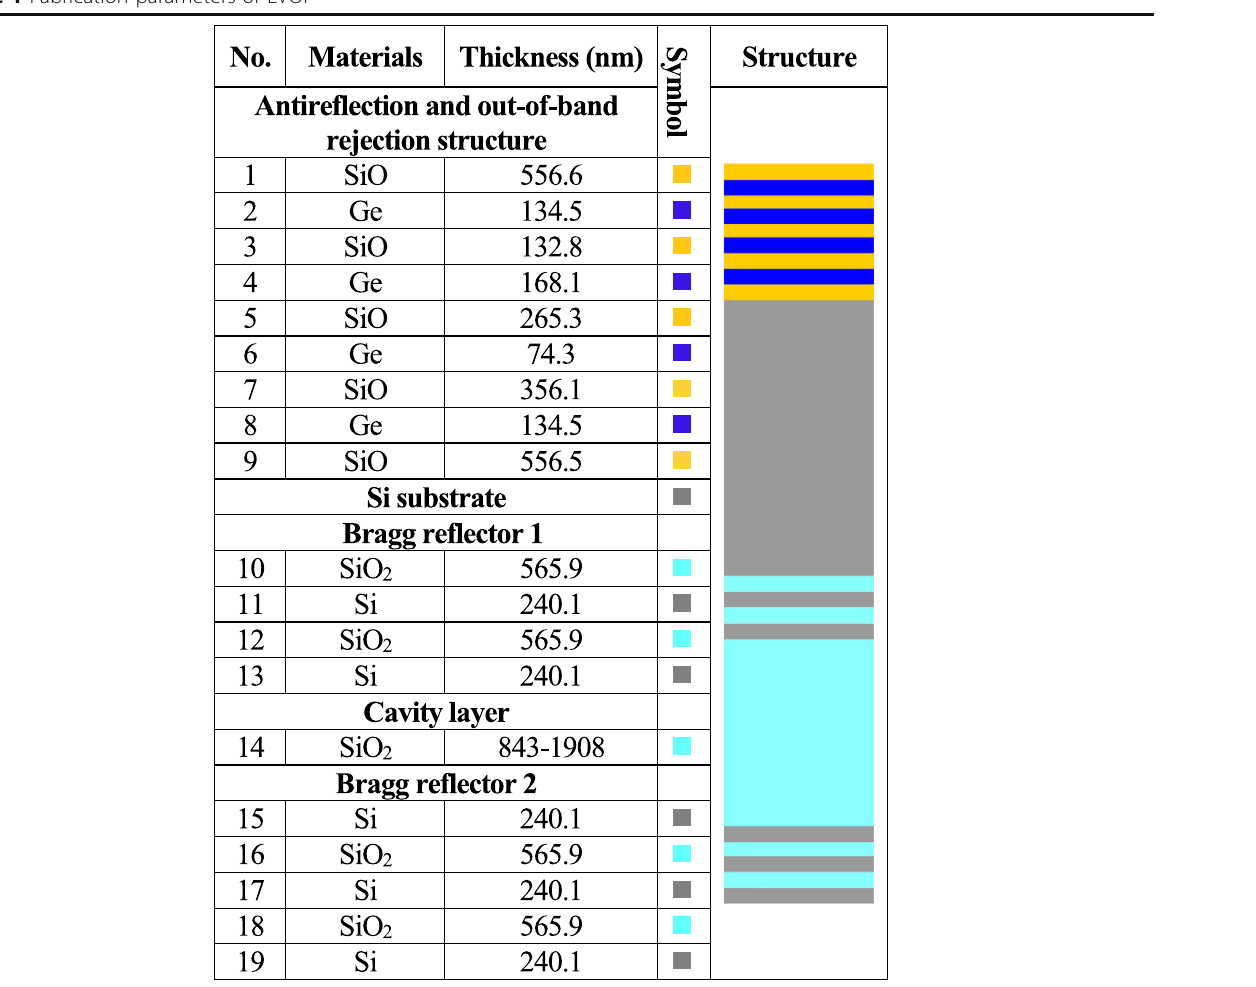
Table 1 Fabrication parameters of